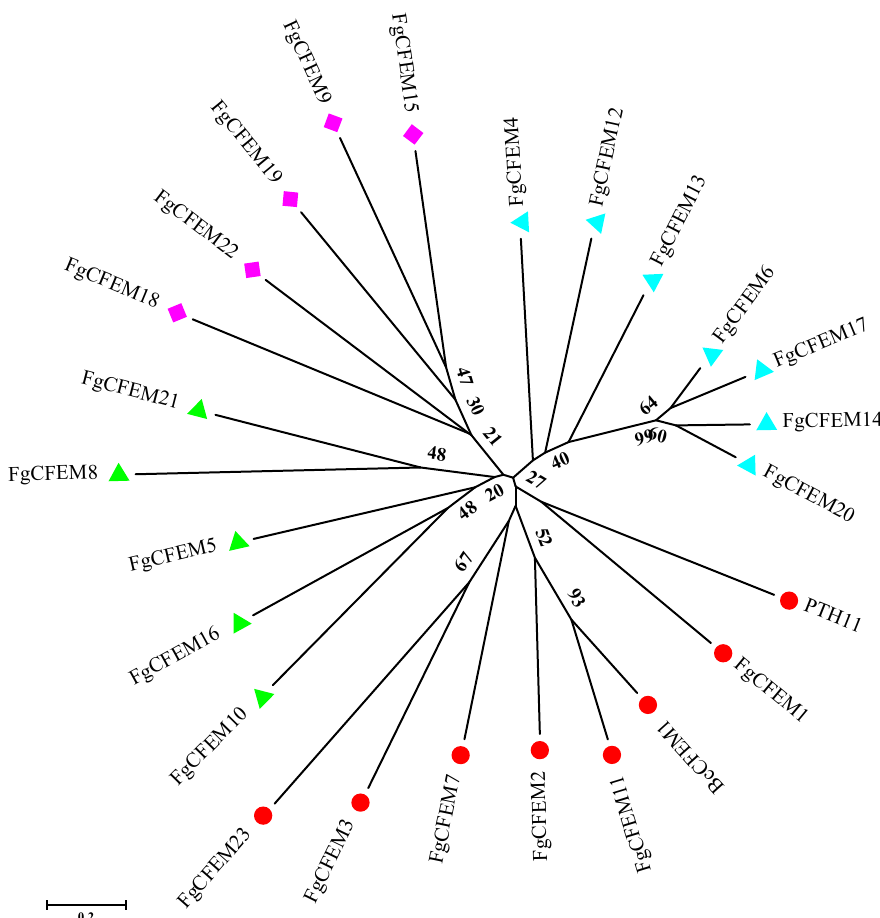
Figure 4. Phylogenetic analysis of the extracted CFEM domains of CFEM proteins in F. graminearum , PTH11 in M. oryzae and BcCFEM1 in B. cinerea. A phylogenetic tree of adjacent connections was constructed based on amino acid sequences of FgCFEMs. The numbers on the nodes represent the percentage of their occurrences in the 1000 bootstrap replicates; the results show that more than 20% of the nodes are supported. The scale bar shows the number of amino acid differences at each site. The different colors indicate different